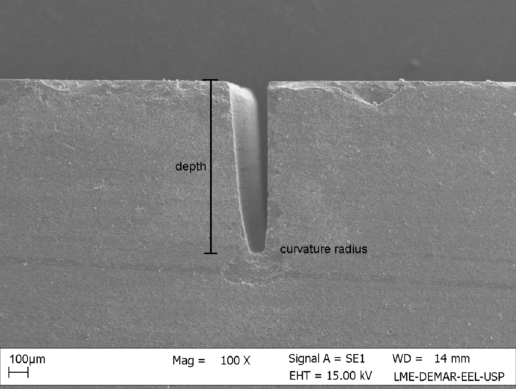
Figure 1. SEM micrograph and description of a